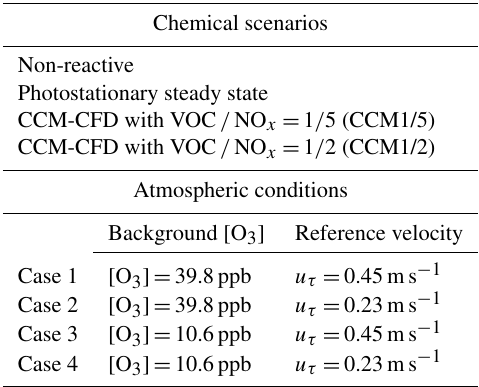
Table 2. Summary of all cases simulated in the 2-D and 3-D geome- tries. The four chemical scenarios are simulated in each atmospheric condition.